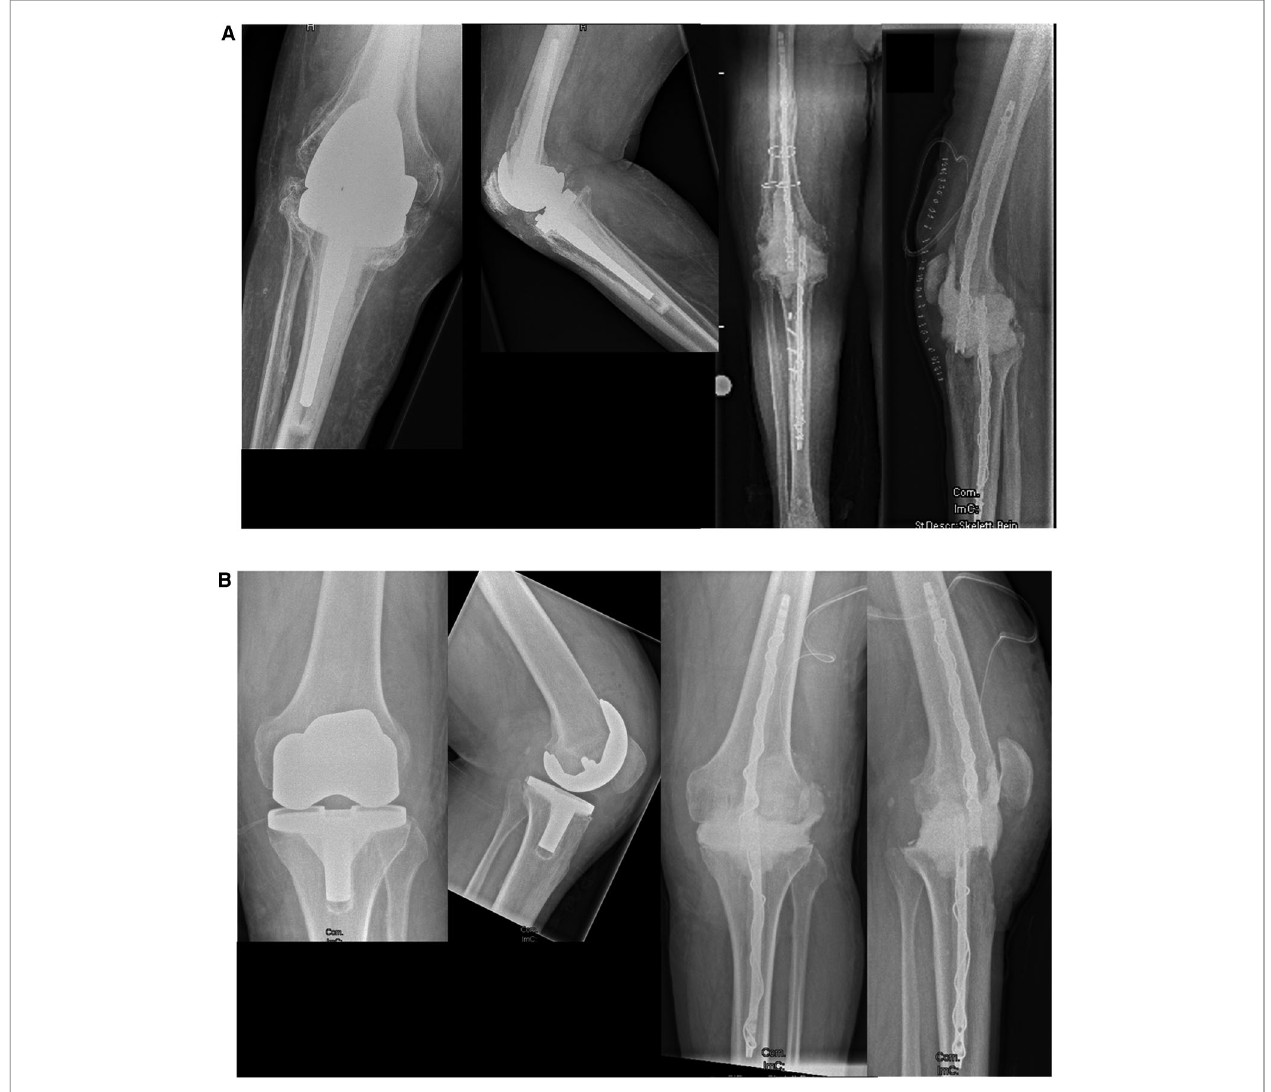
FIGURE 2 | Pre-operative x-rays of ( A ) an infected rotating hinge prosthesis and ( B ) an infected bicondylar surface replacement prosthesis are shown in the left panel. Post-operative images after explantation, debridement, and temporary arthrodesis are shown in the right